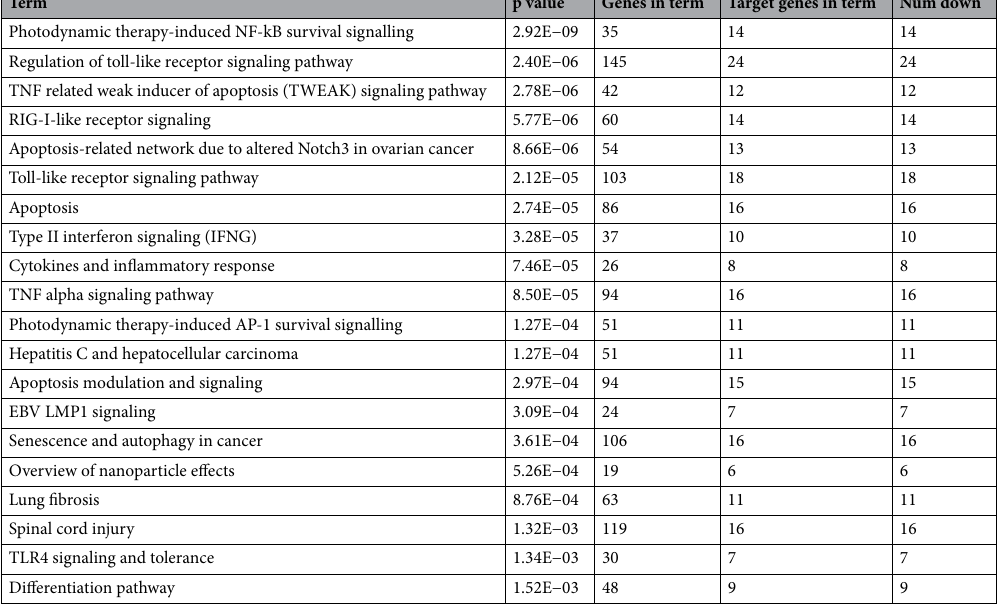
Table 3. Pathway analysis of downregulated